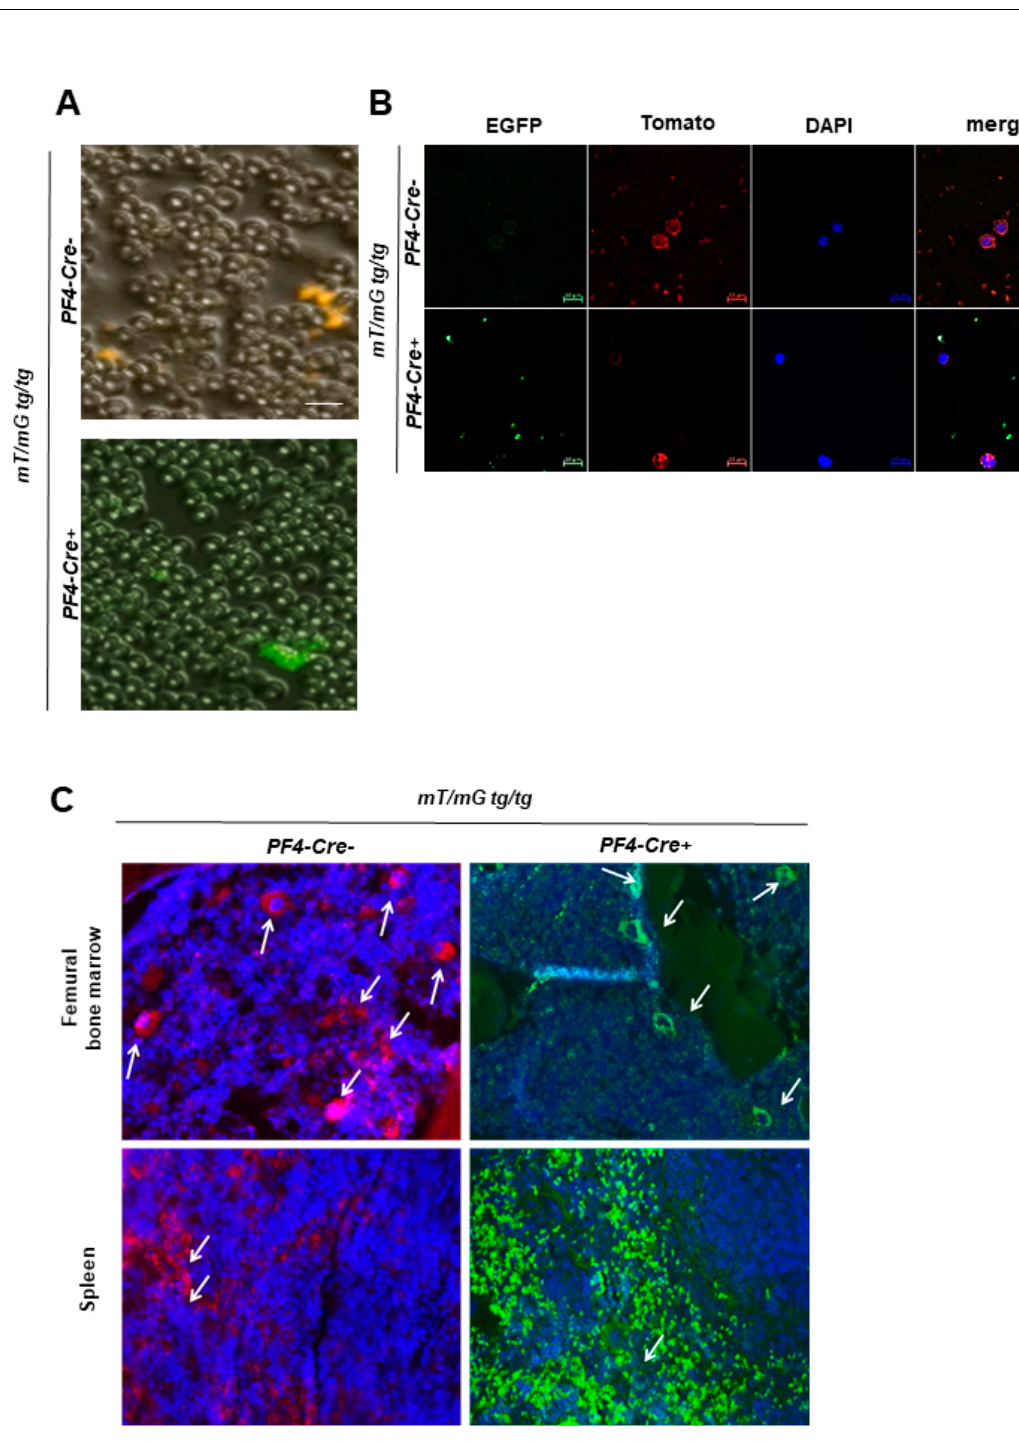
Figure 2. mT and mG fluorescence of platelets and megakaryocytes in blood smear, spleen and femur of mT/mG; PF4- Cre transgenic mice. ( A , B ) Blood smear samples of mT/mG PF4-Cre negative and positive mice were analyzed for mT and mG fluorescence of blood cells. ( A ) Representative images of mT (upper panel) and mG (lower panel) fluorescence of platelets in blood smear of transgenic mice using differential interference contrast (DIC), n = 8–10, scale bar 20 µ m. ( B ) Representative images of single channels are shown representing either mT or mG fluorescence. Additionally, DAPI staining was performed to identify nucleus containing cells such as leukocytes in blood smear, n = 8–10, scale bar 10 µ m. ( C ) Analysis of hematopoietic active tissue (spleen and femoral bone marrow) in mT/mG;PF4-Cre mice. Representative images of mT fluorescence (mT/mG;PF4-Cre negative) and mG fluorescence (mT/mG;PF4-Cre positive). DAPI was used to stain nuclei in spleen and femur. White arrows indicate megakaryocytes. n =